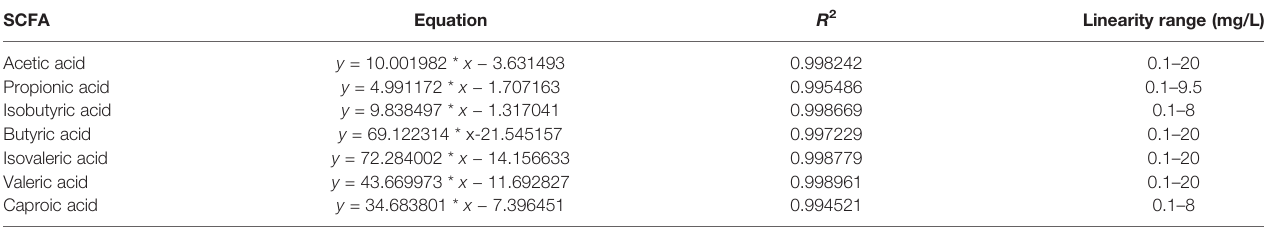
TABLE 4 | Equation of linear regressions detected by standard samples via GC-MS. SCFA Equation R 2 Linearity range (mg/L) Acetic acid y = 10.001982 * x − 3.631493 Propionic